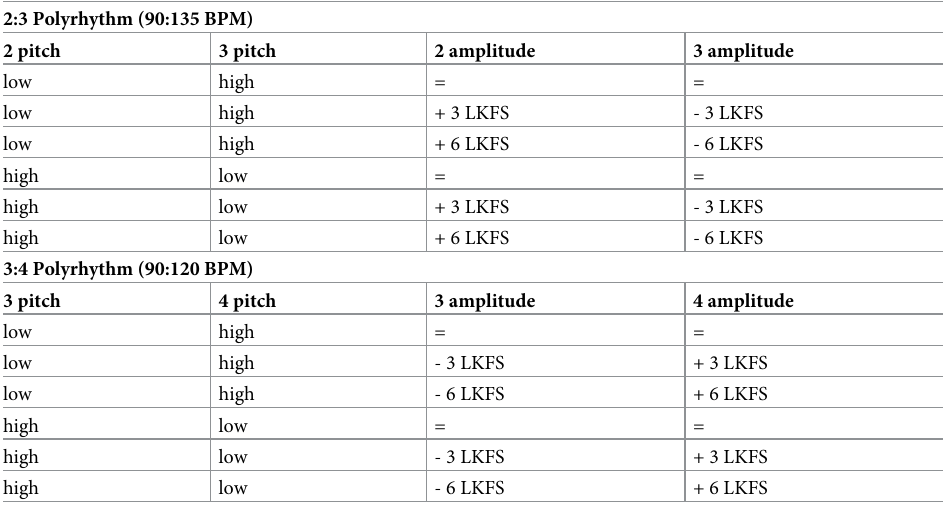
Table 3. The 12 pitch